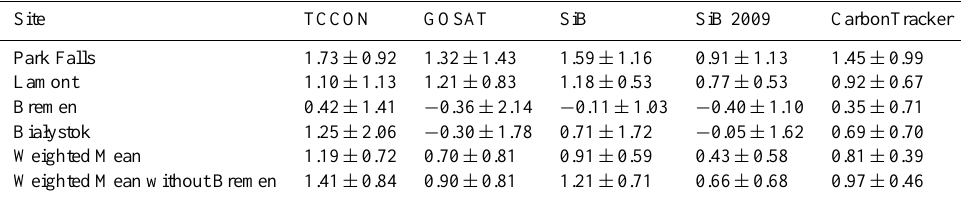
− δT relationship in ppmK − 1 calculated from the TCCON measurements and the model runs. The errors are the Table 4. Slopes of 1 X CO 2 standard errors on the linear fits. The respiration-weighted surface temperature ( δT ) are from August surface temperatures.